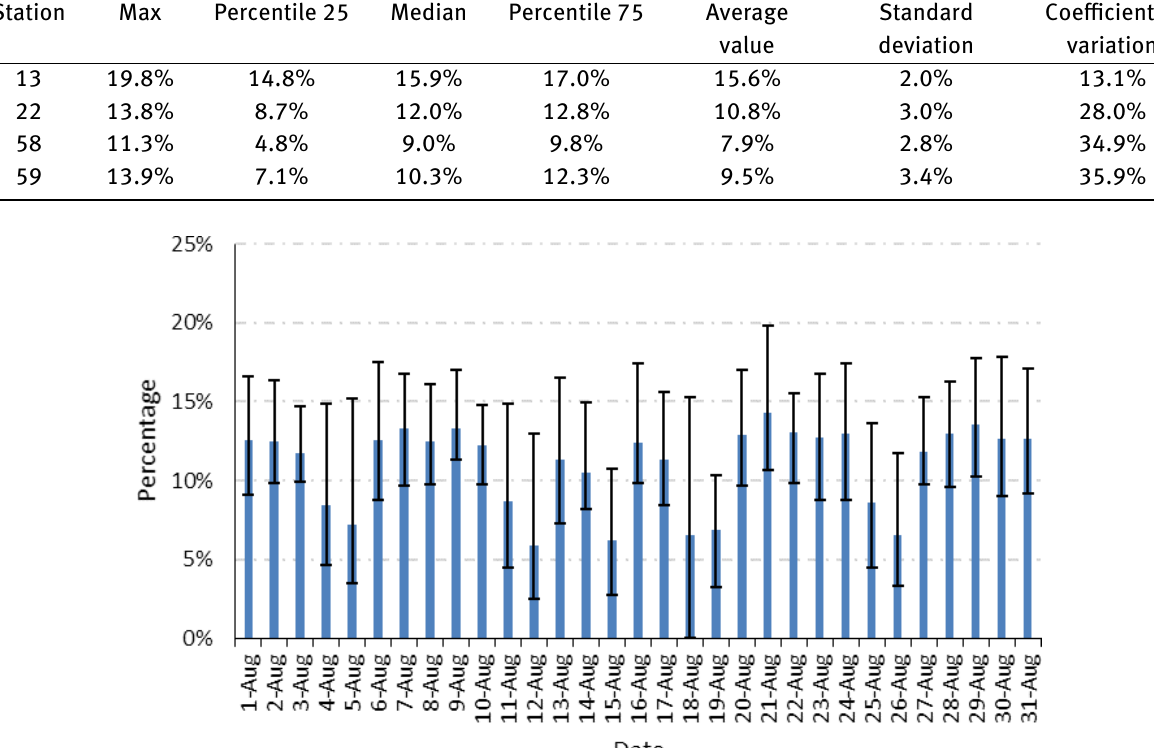
Figure 6: Shares of overloaded category 11 vehicles averaged for all stations, on particular measurement days (whiskers represent the minimum and maximum